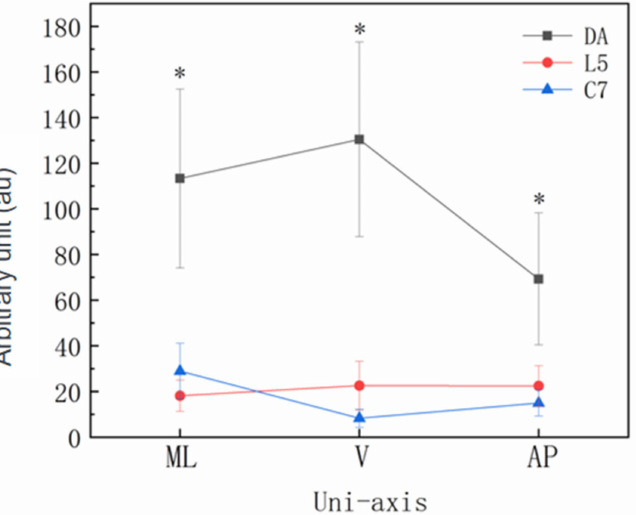
Figure 5. The differences in PlayerLoad responses between the dominant ankle (DA), the fifth lumbar vertebra (L5) and the seventh cervical vertebra (C7) for the Zapateado-3 footwork in three planes: medial-lateral (ML), vertical (V) and anterior-posterior (AP). * Denotes a significant main effect for the unit